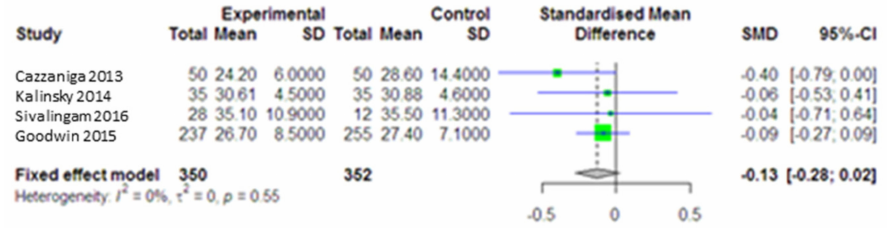
Figure 5. Forest plot of the meta-analysis to compare BMI between intervention and control groups.